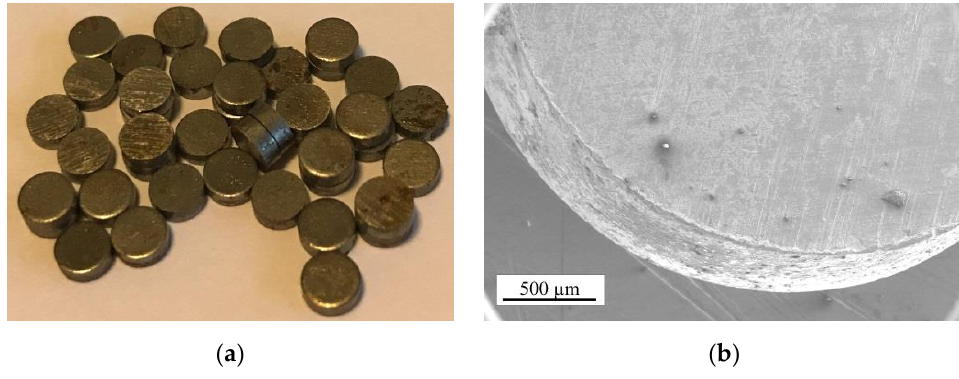
Figure 1. Image of the waste-metal particle: ( a ) overall view, ( b ) SEM separate particle.